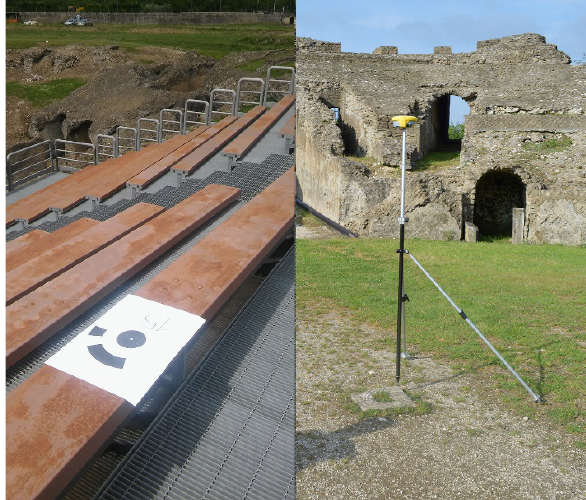
Figure 6: GCP measurement phase: right panel on photogrammetric targets, left panel on natural